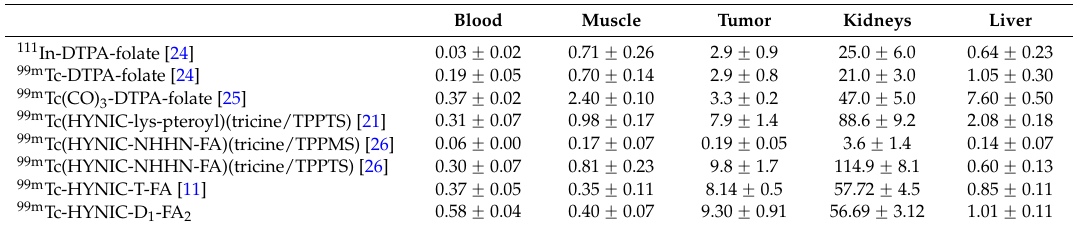
Table 3. Biodistribution data (4 h p.i.) of radiofolates in athymic nude mice bearing KB tumor xenografts (%ID/g, mean ˘